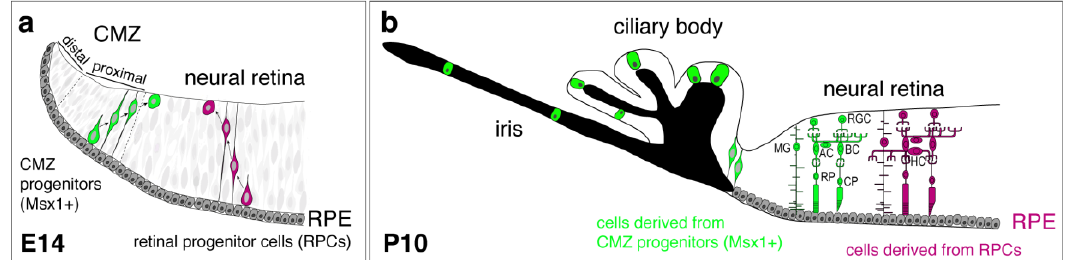
Figure 3. Schematic representation of lineage tracing from progenitors of the ciliary marginal zone (CMZ) or neural retina in mouse. ( a ) At E14, retinal progenitor cells (RPCs) (magenta) are the main contributor to retinal neurogenesis, but Msx1+ progenitors (green) in the proximal CMZ migrate towards the neural retina and contribute to retinal neurogenesis at the periphery of the retina. ( b ) At P10, cells derived from Msx1+ progenitors (green) produce most retinal cell types, although with a different ratio than cells derived from RPCs (magenta). Also, Msx1+ progenitors (green) contribute to non-pigmented epithelial cells of the ciliary body and the cells in the iris. RPE: retinal pigmented epithelium, RGC: retinal ganglion cells, BC: bipolar cells, AC: amacrine cells, MG: Müller glia, RP: rod photoreceptors, CP: cone photoreceptors, HC: horizontal cells. Adapted from Marcucci et al., 2016 [151] and Bélanger et al., 2017 [152].